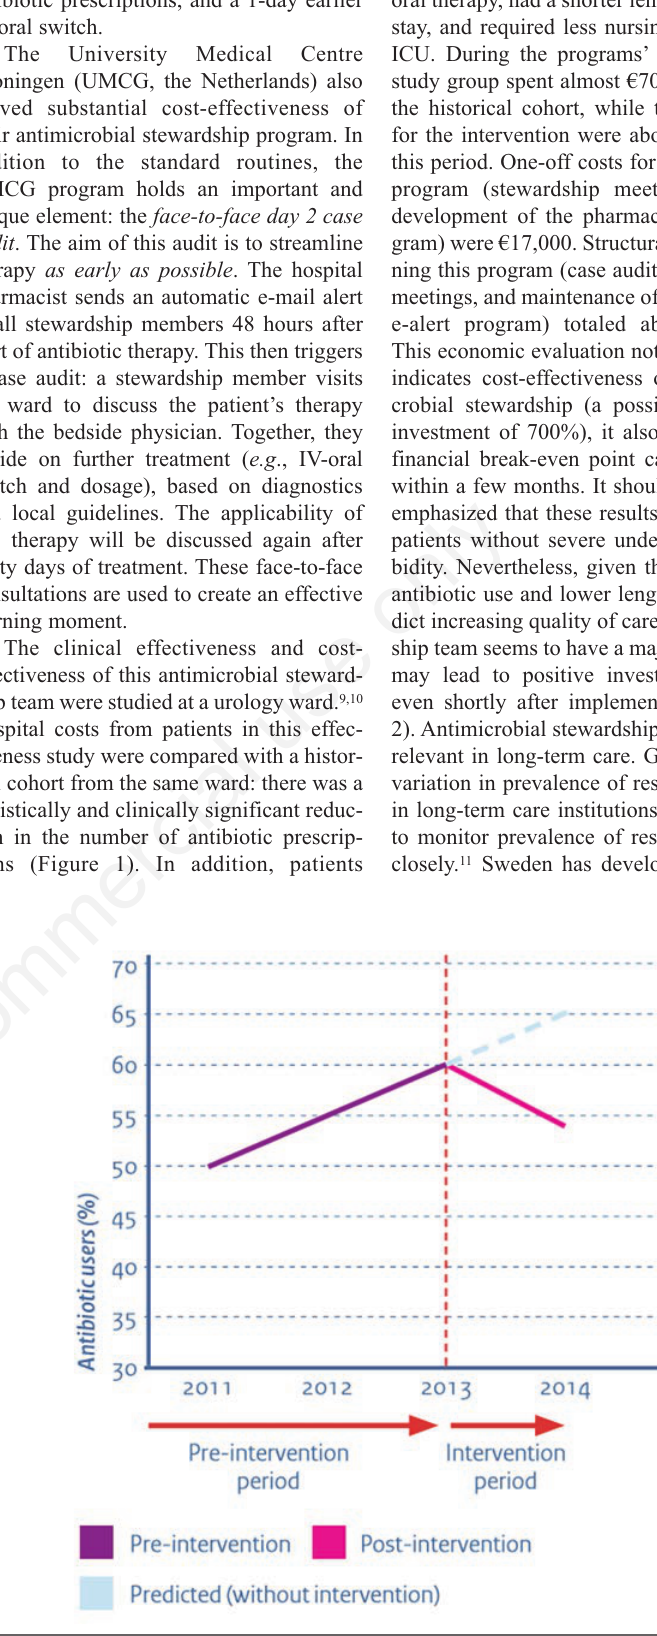
Figure 1. Antibiotic use on a urology department before and after implementation of the antimicrobial stewardship